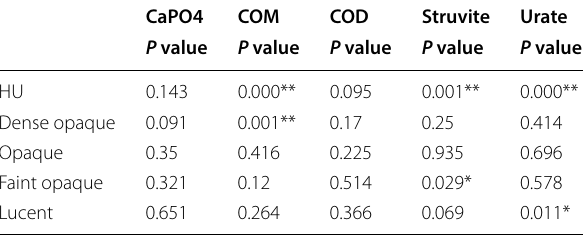
*Statistically significant difference ( P level <